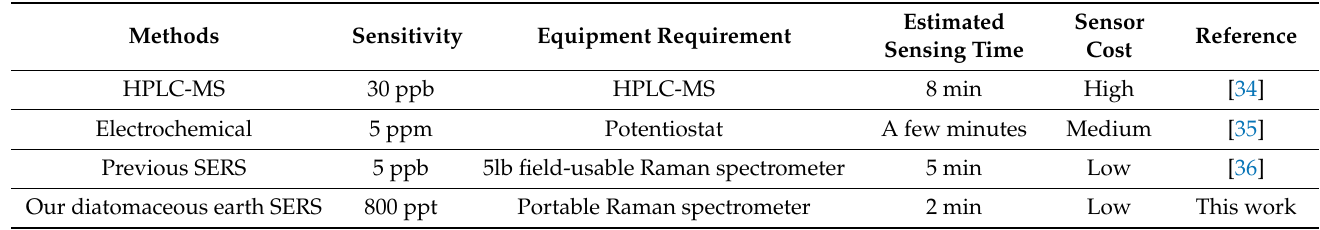
Table 1. Different methods of sensing fentanyl quantitatively in practical